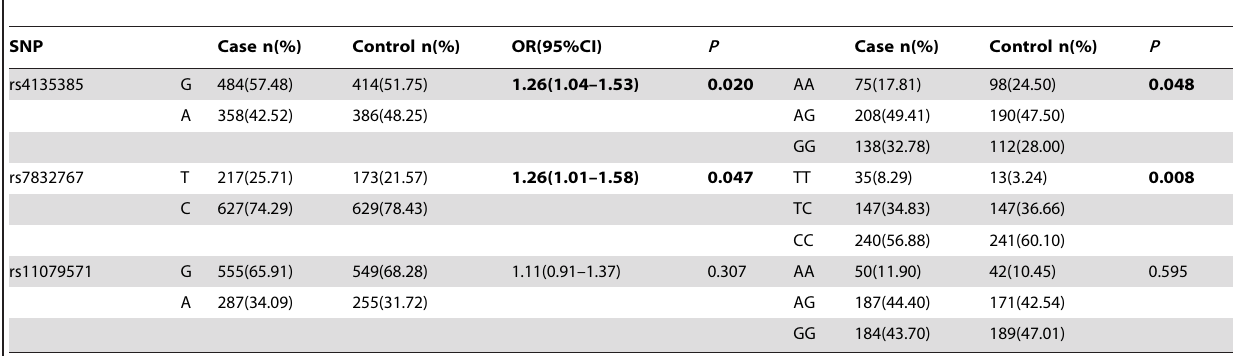
Table 2. Comparison of Wnt pathway gene polymorphisms between TB patients and controls.